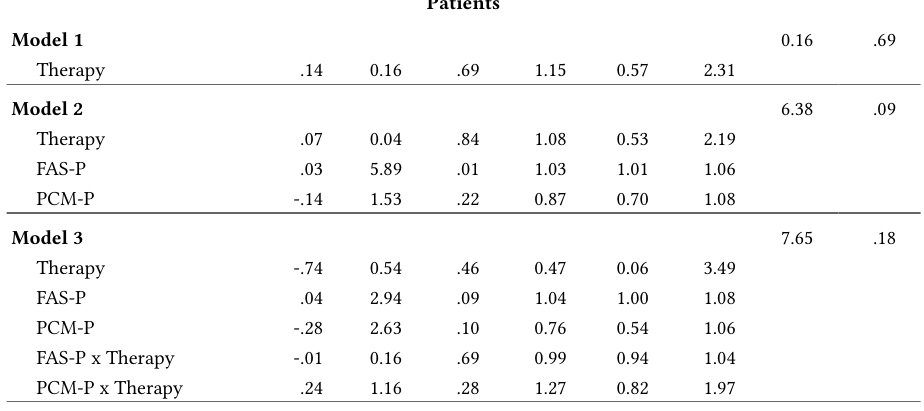
Variable B Wald